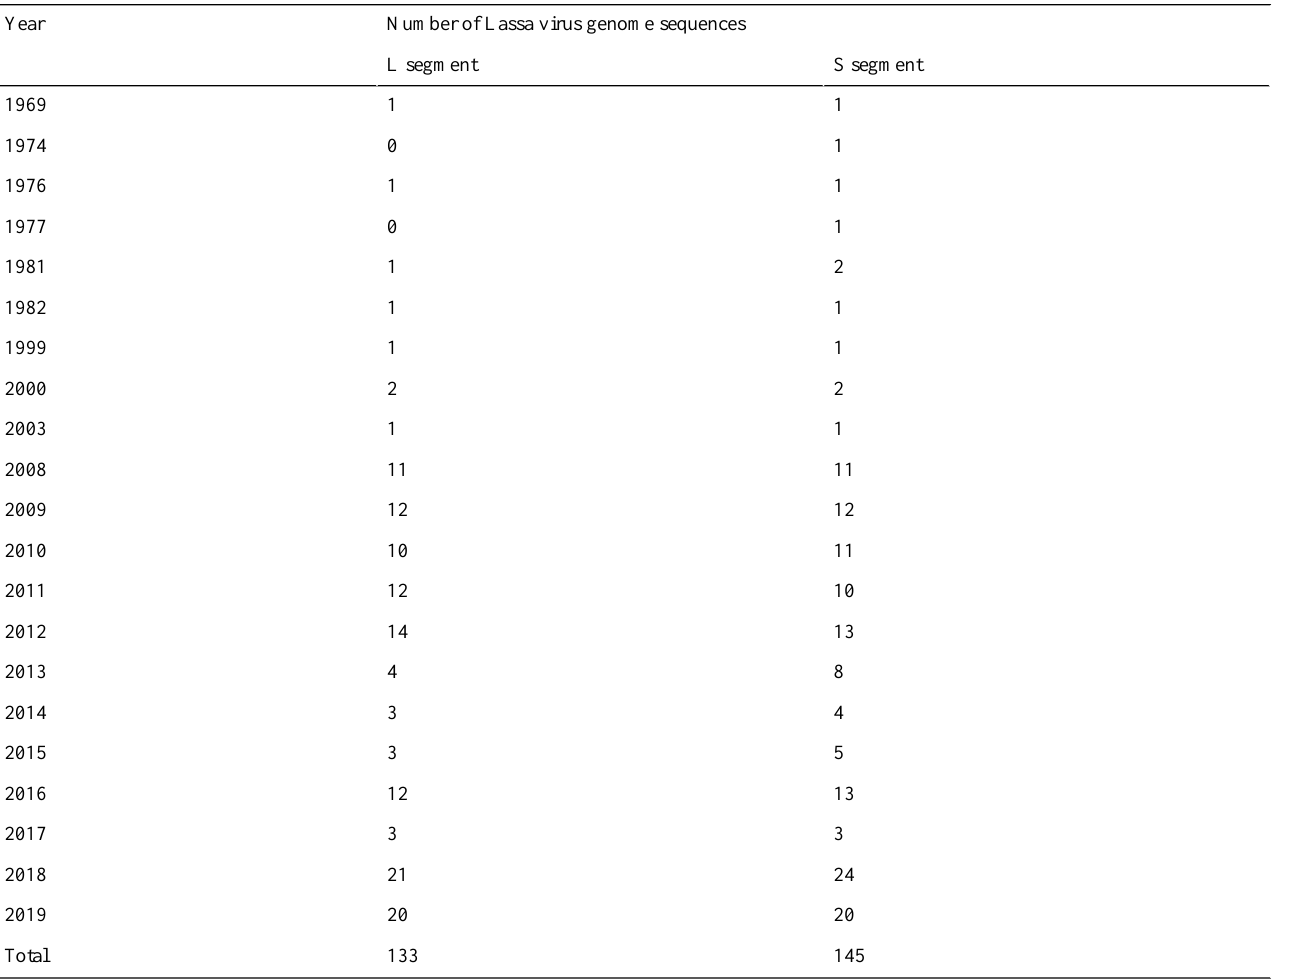
Table 1. Number of sequences of the L and S segments of the Lassa virus genome from 1969 to 2019 used in this study. Number of Lassa virus genome sequencesYear